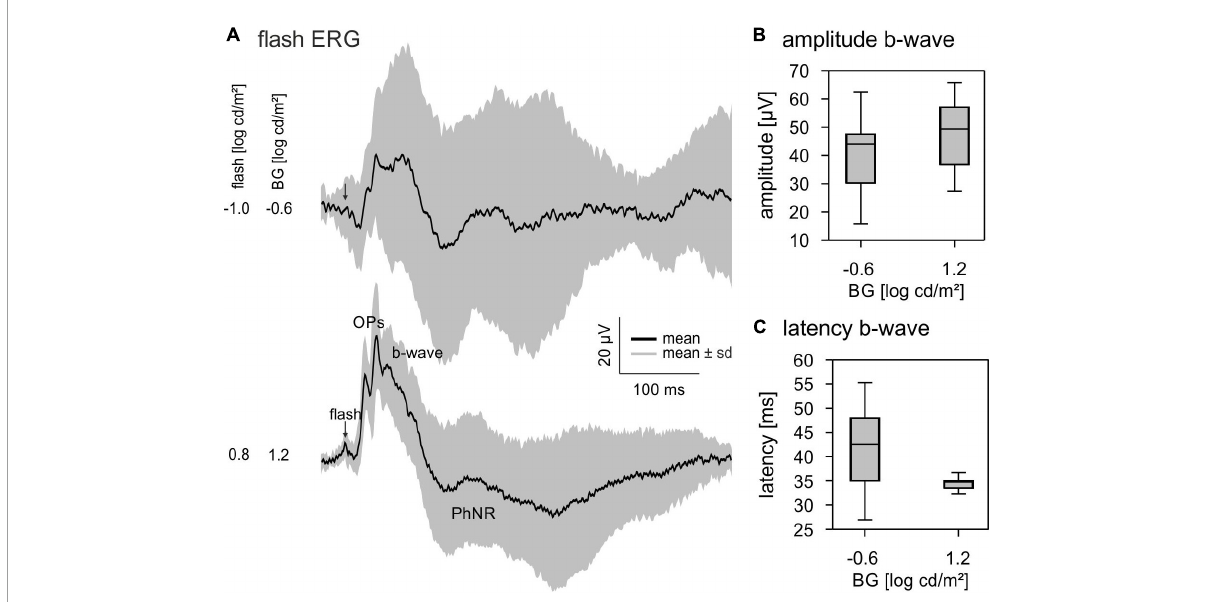
FIGURE3 Flash electroretinograms (ERGs). (A) Averaged ERG responses to a –1.0 log cd s/m 2 flash on a –0.6 log cd/m 2 BG and a 0.8 log cd s/m 2 flash on a 1.2 log cd/m 2 BG. Black lines show the averaged signals, the grey area represents mean ± standard deviation. (B) Quantitative analysis of the b-wave amplitude and (C) latency. Boxplots show median and 25 and 75% quartiles. Whiskers represent the minimal and maximal values of the dataset.